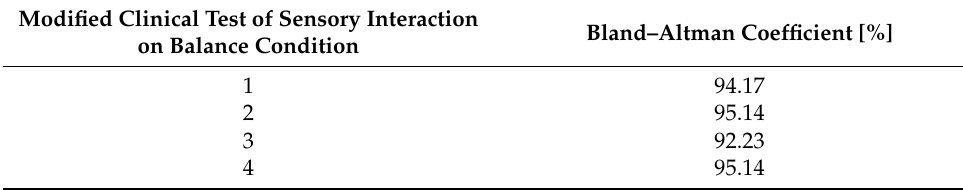
Table 3. Compliance results between MediPost and static